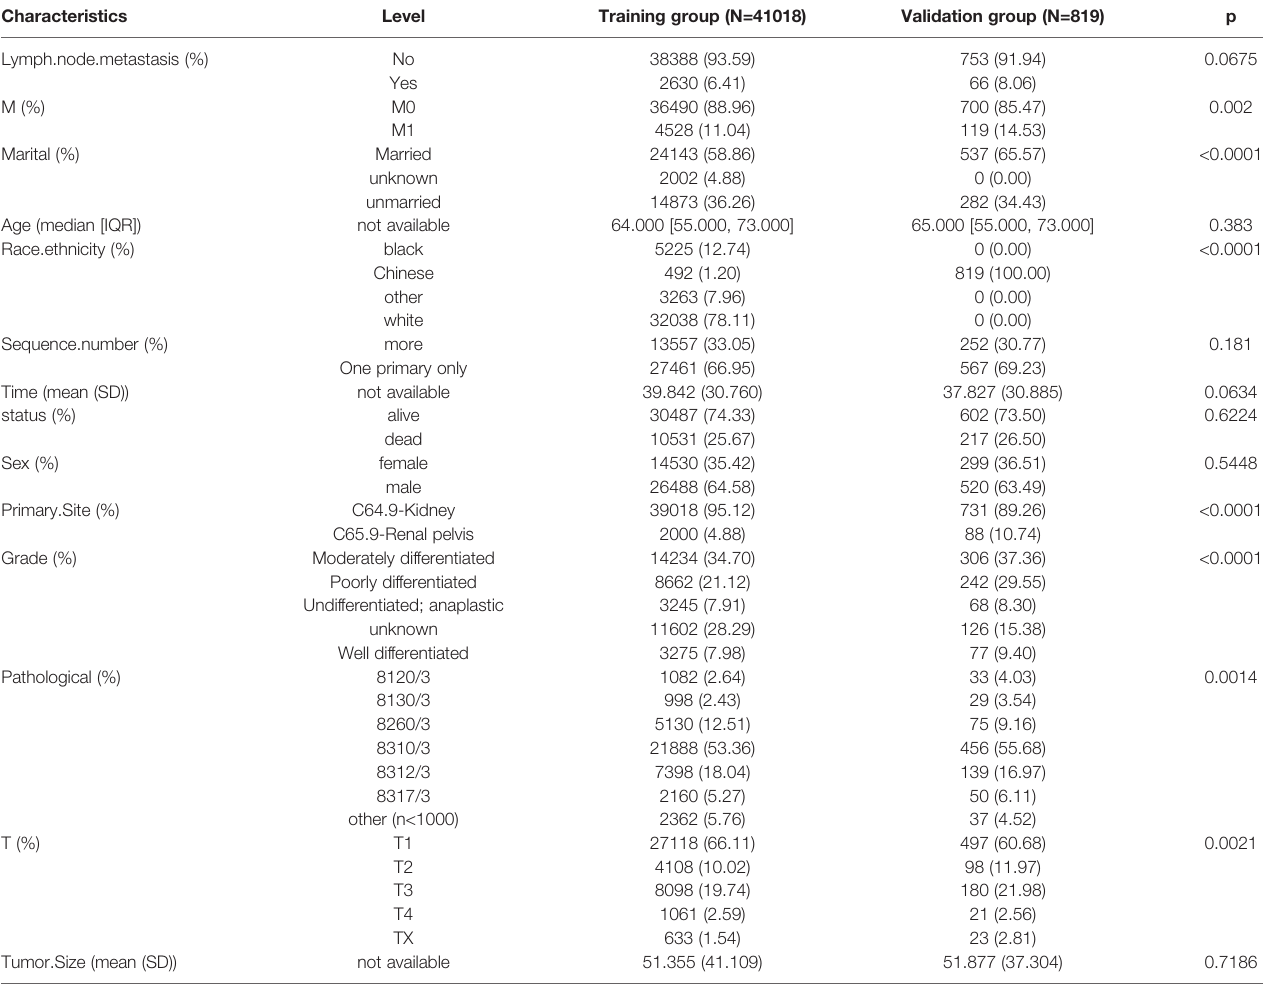
TABLE 1 | Baseline of patients in the training and validation groups.